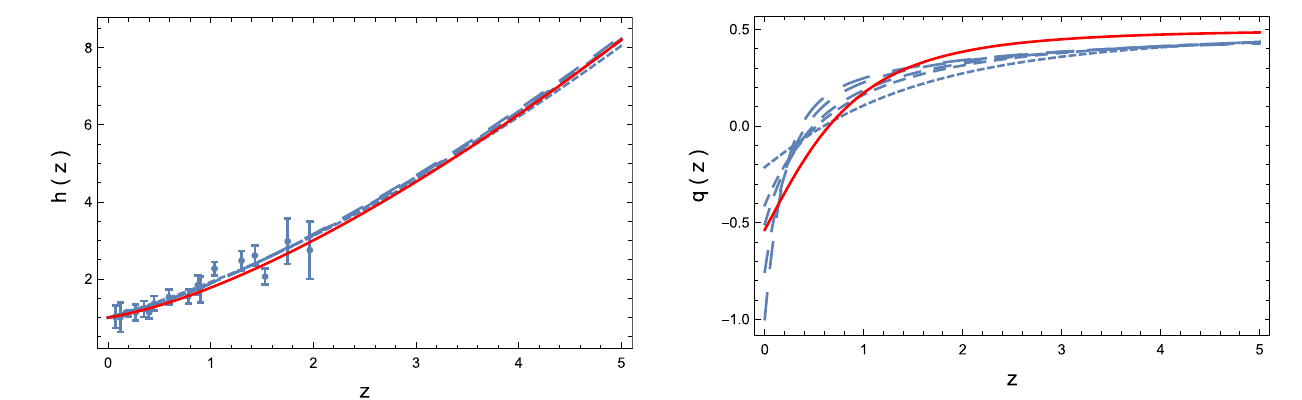
Fig. 5 Variation in the deceleration parameter q as a function of the redshift z in the Barthel–Kropina-FLRW dark energy model for dif- ferent values of the parameter w of the dark energy equation of state: w = 1 . 45 (short dashed curve), w = 1 . 85 (dashed curve), w = 2 . 05 (longdashedcurve), w = 2 . 55(ultra-longdashedcurve),and w = 3 . 05 (ultra-ultra-long dashed curve), respectively. The red solid line repre- sents the prediction of the (cid:2) CDM model. The initial conditions used to numerically integrate the system of cosmological evolution equations are f ( 0 ) = 0 . 33, u ( 0 ) = 0 . 51, and h ( 0 ) = 1, respectively